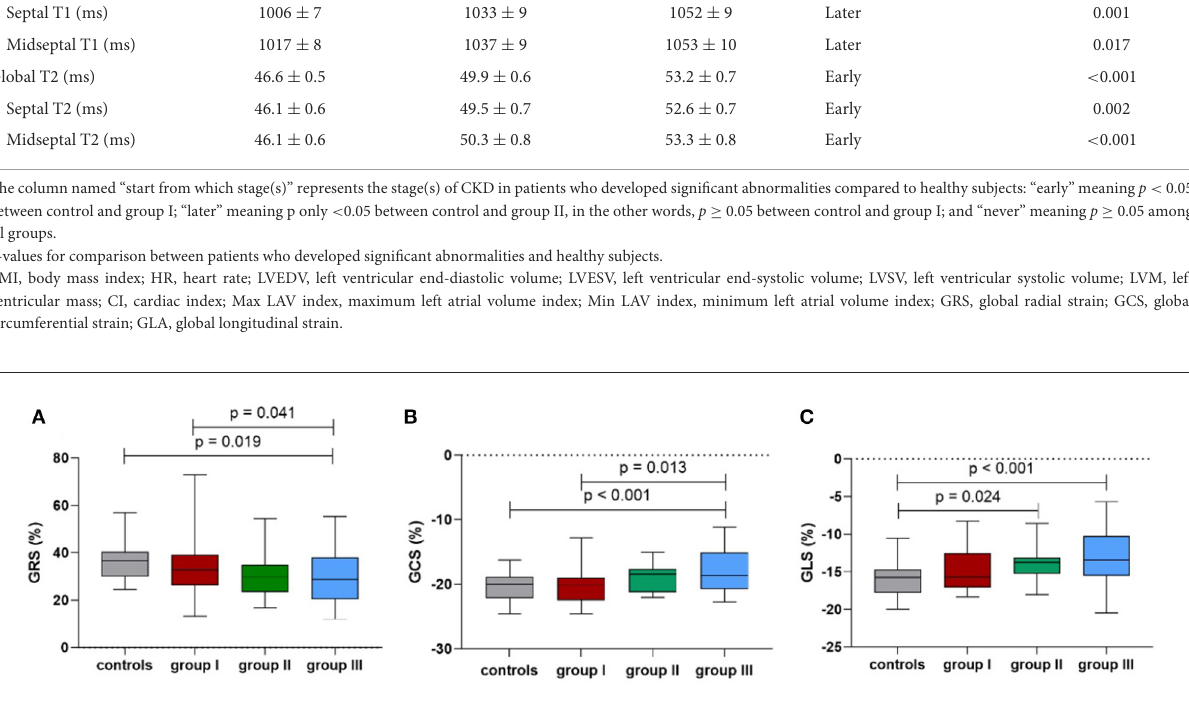
CKD patients compared with healthy subjects, and increasing native T1 and T2 values with the advancing CKD stages, which are consistent with previous studies (8, 18). In addition, a negative correlation between T2 values and GFR was also found in patients with heart failure (20), supporting the finding of our trial. Other previous studies demonstrated that native T1 mapping improved the diagnostic accuracy of CMR in estimating myocardial fibrosis (16, 21). In